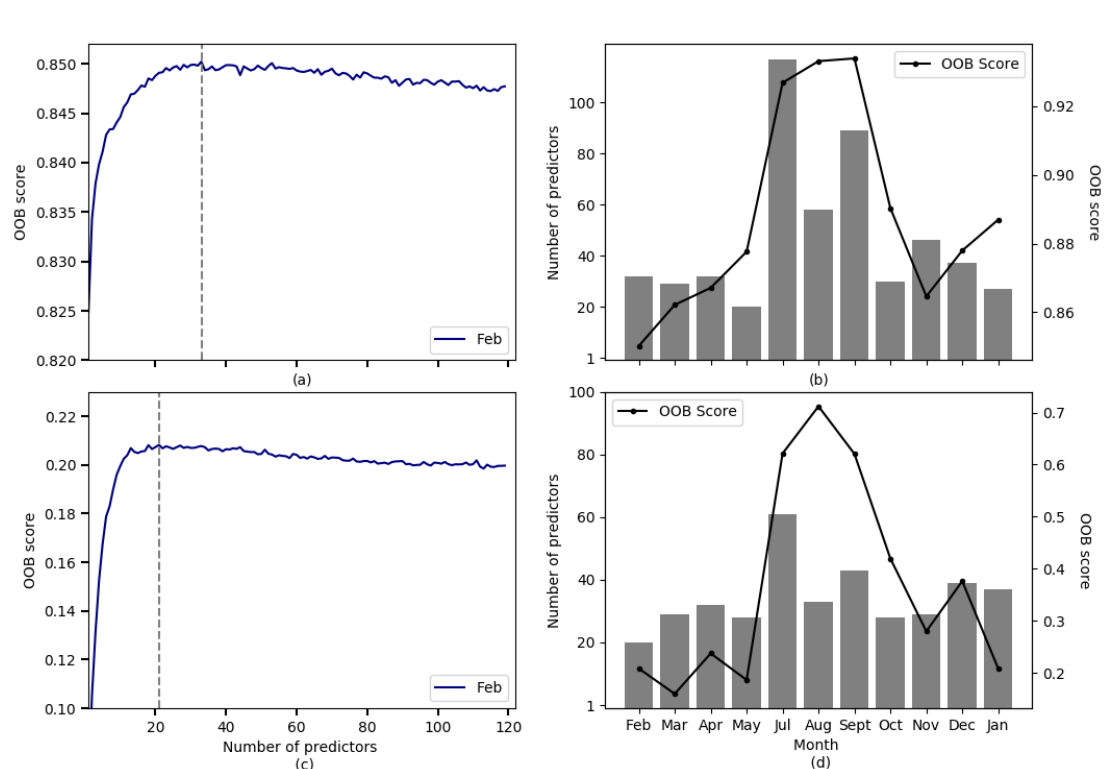
Figure 3. Results of the feature elimination. ( a ) OOB score vs. number of features for RF classification (rain area) in February; ( b ) Number of features selected for RF classification and related OOB score for the time period; ( c ) OOB score vs. number of features for RF regression (rain amount) in February; ( d ) Number of features selected for RF regression and related OOB